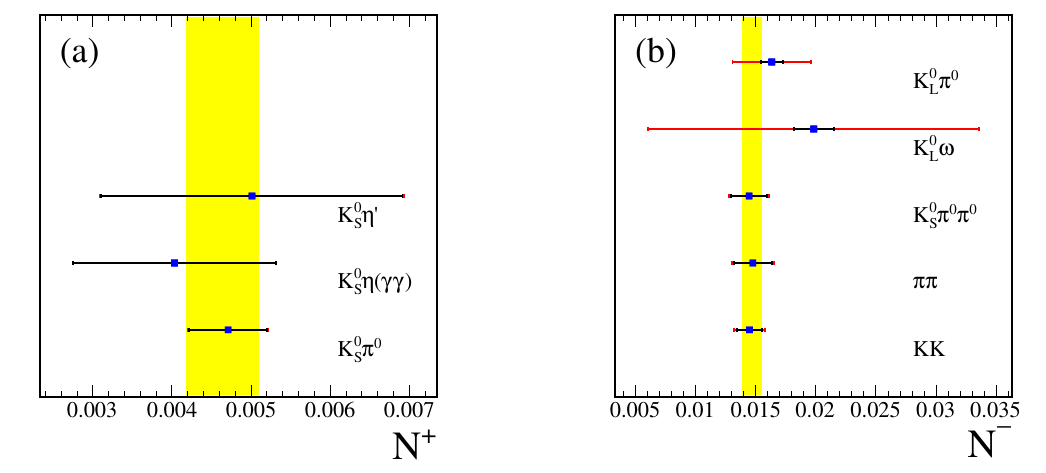
Figure 8 . (a) N + values for the CP -odd modes and (b) N (cid:0) values for the CP -even modes. The yellow region shows the average value. The horizontal black and red error bars show the statistical and the total uncertainty,